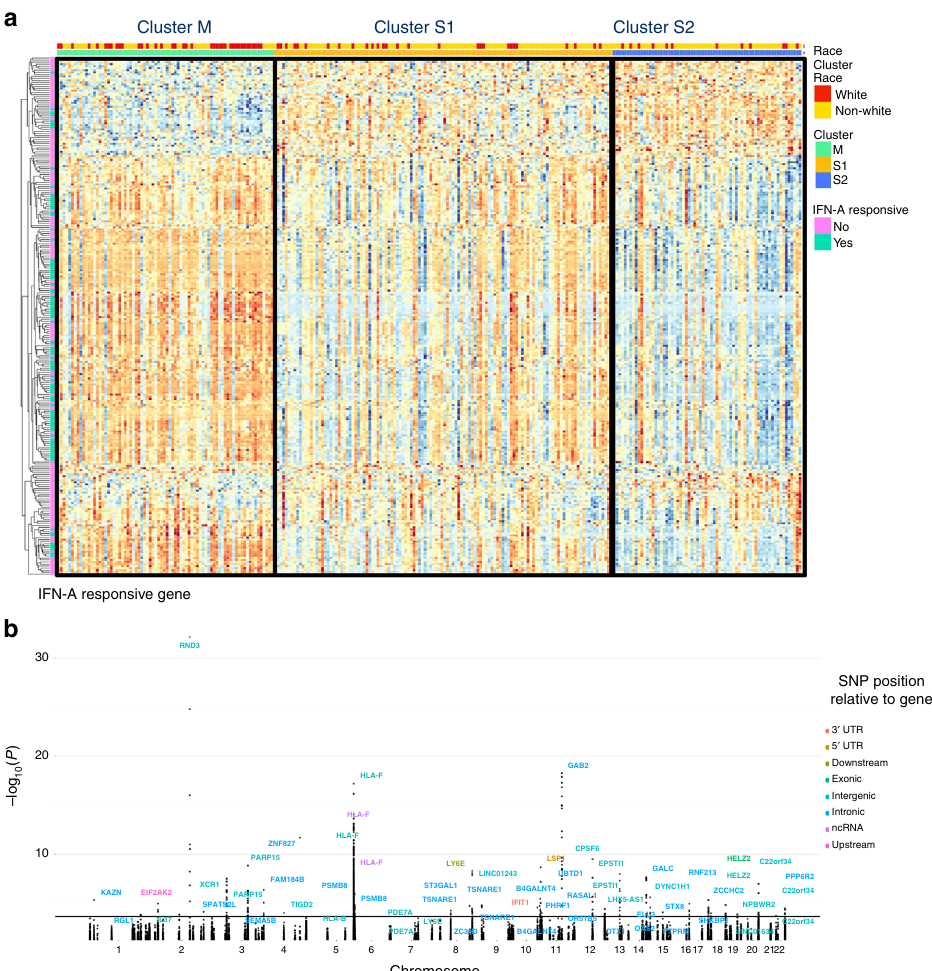
Fig. 3 Cluster associated CpGs and meQTL associations. a Heatmap of CpGs signi fi cantly associated with clinical cluster (FDR < 0.1) b Manhattan plot shows − log 10 ( p -value) for associations between cluster-associated CpGs and all SNPs within 1 Mb of each CpG. For each CpG with a signi fi cant meQTL (FDR < 0.05), the most signi fi cant variant is labelled with its corresponding